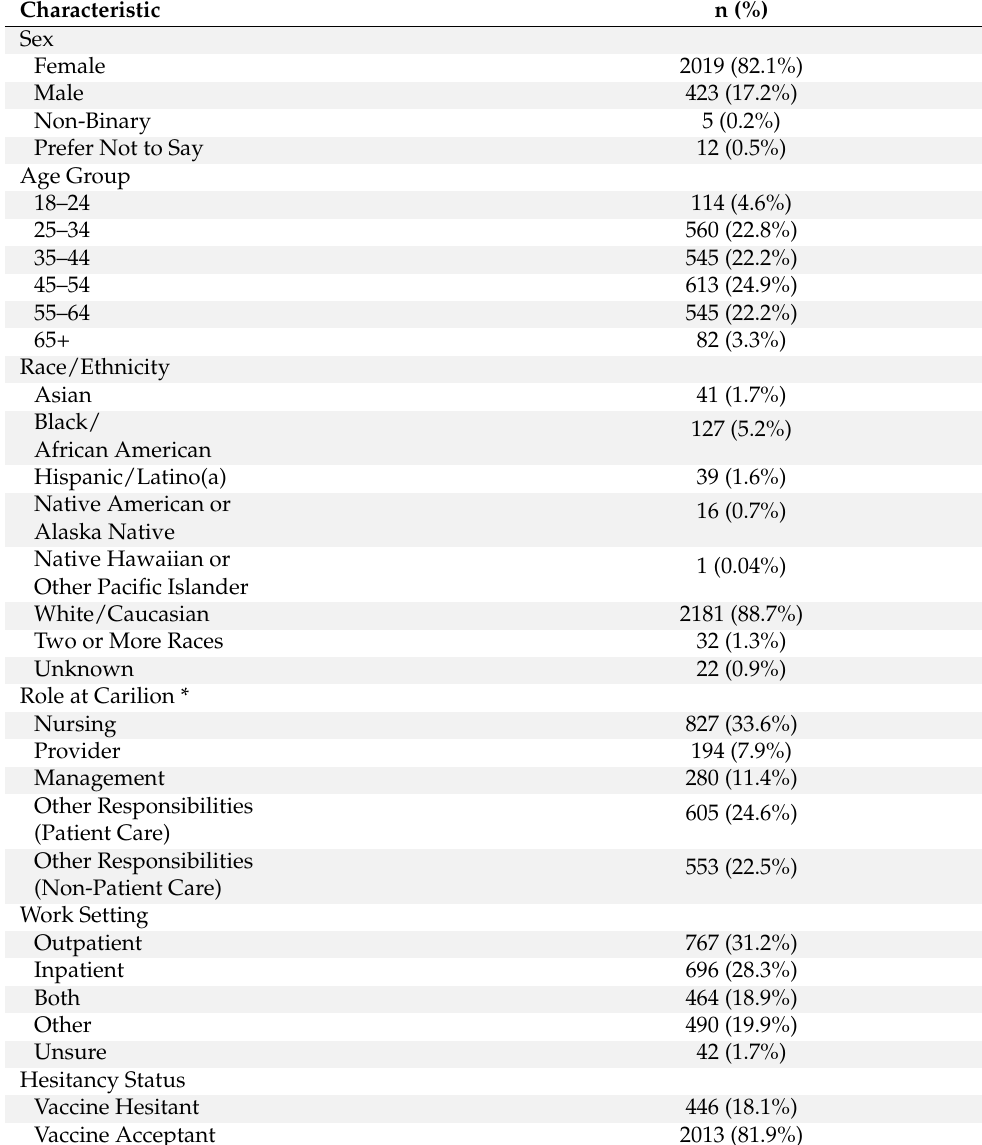
Table 1. Demographic and Other Healthcare Worker Characteristics (N =